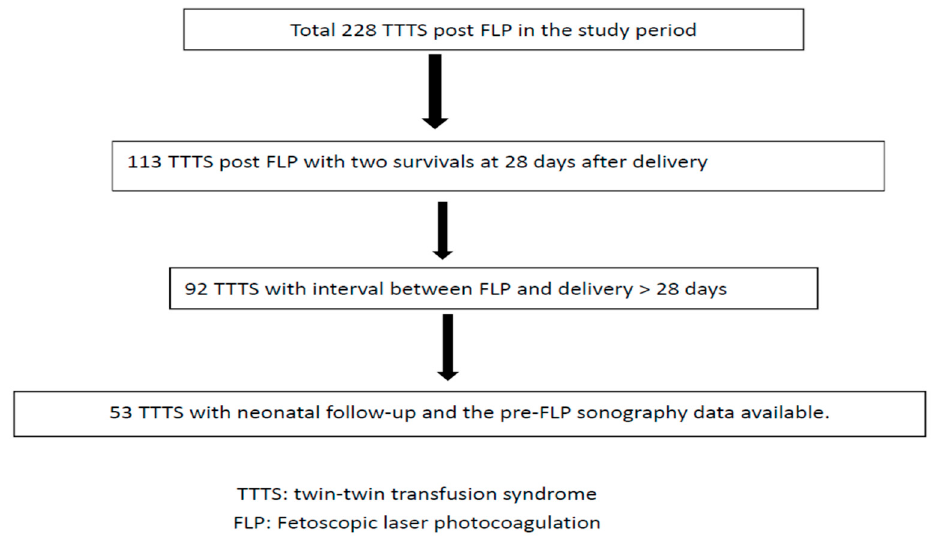
Figure 1. Flowchart of twin–twin transfusion syndrome post fetoscopic laser photocoagulation included in this study.